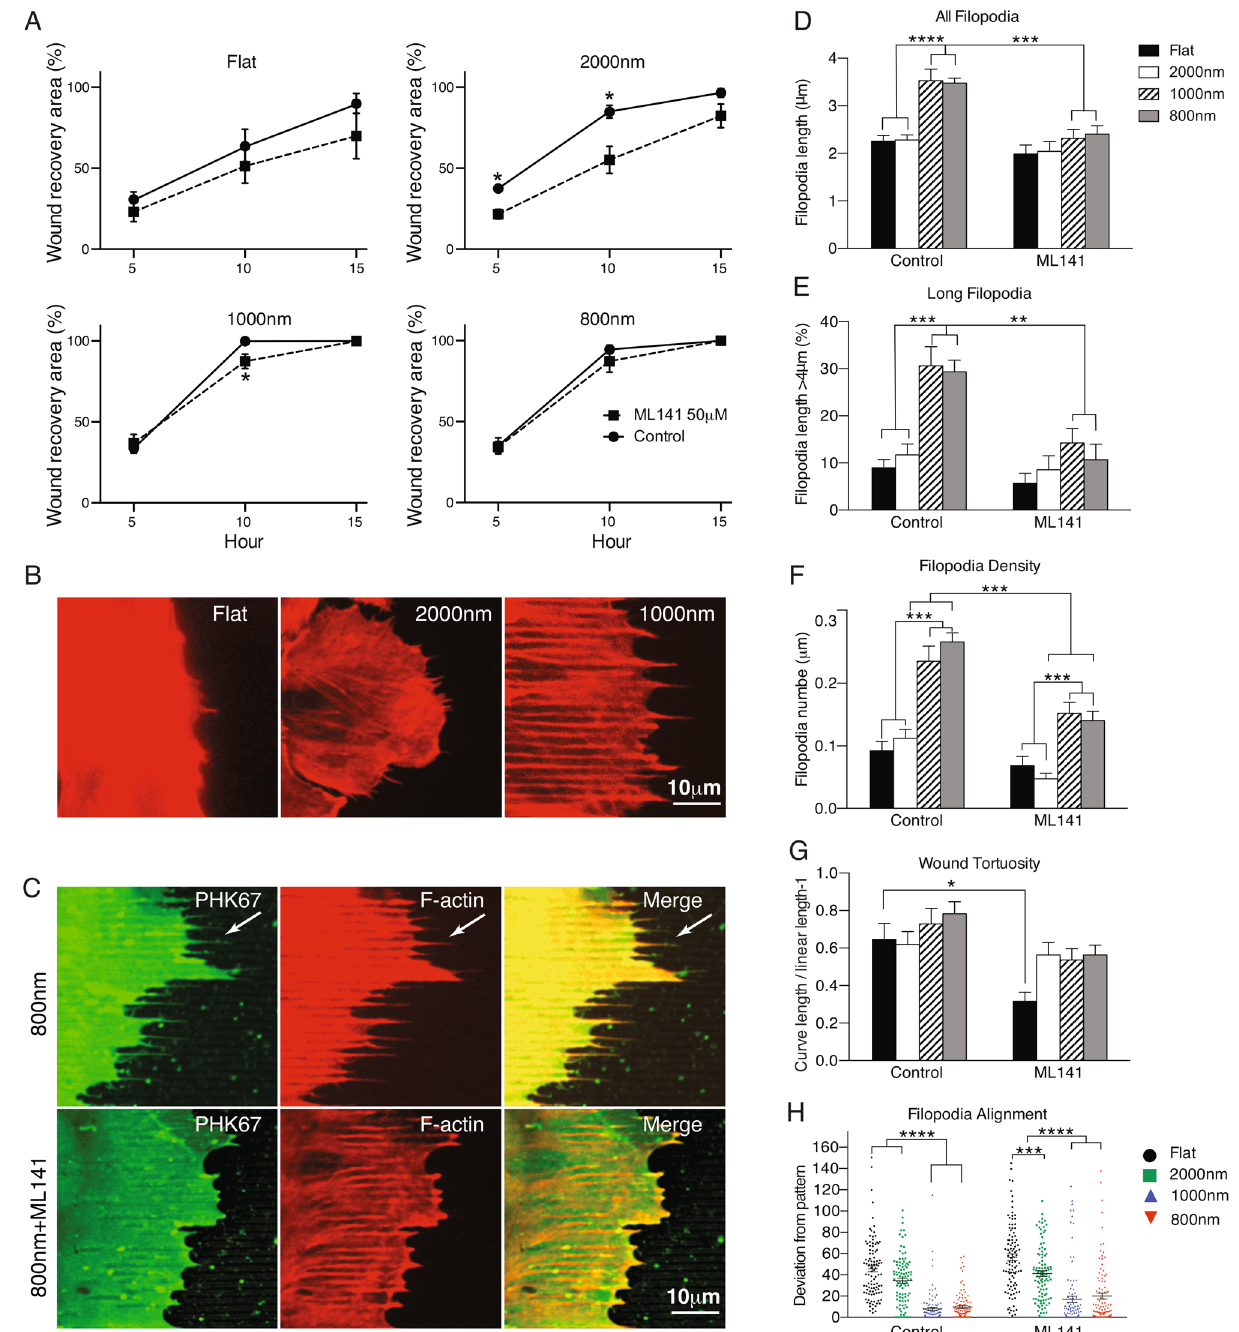
Figure 6. Filopodia formation is required for wound recovery of corneal epithelial cells. ( A ) Analysis of wound recovery indicated that the Cdc42 inhibitor induced delayed wound healing in all topographies but were significantly decreased on flat and 2000 nm patterned silk films (* indicate p < 0.05, when compared a time point between untreated and ML141 treated group. Values are means ± S.E.M.). ( B ) Filopodia was visualized by labeling F-actin with Phalloidin Alexa 568. Filopodia was clearly extended and aligned with the topography of 800 nm silk films. ( C ) Comparison of F-actin and membrane labeling of filopodia (PHK67) of cells on 800 nm silk films with or without ML141 treatment. ( D – H ) More than 100 filopodia were quantified and analyzed for extension of filopodia length, percentage of long filopodia population, and filopodia density. They were higher on silk films with smaller topography and always decreased upon inhibitor treatment. ( G ) The tortuosity analysis of wound edge showed that small topography induced more lamellipodia spreading than 2000 nm and flat silk films. ( H ) Filopodia alignment analysis showed that filopodia were more aligned with small topography than 2000 nm and flat silk films. After ML141 treatment, the tortuosity and alignment were reduced (N = 100). Angles between pattern axis and filopodia were measured and plotted (* indicates p < 0.05, ** indicates p < 0.005, ***indicates p < 0.0005 when compared between groups and between treatments. Values are means ±